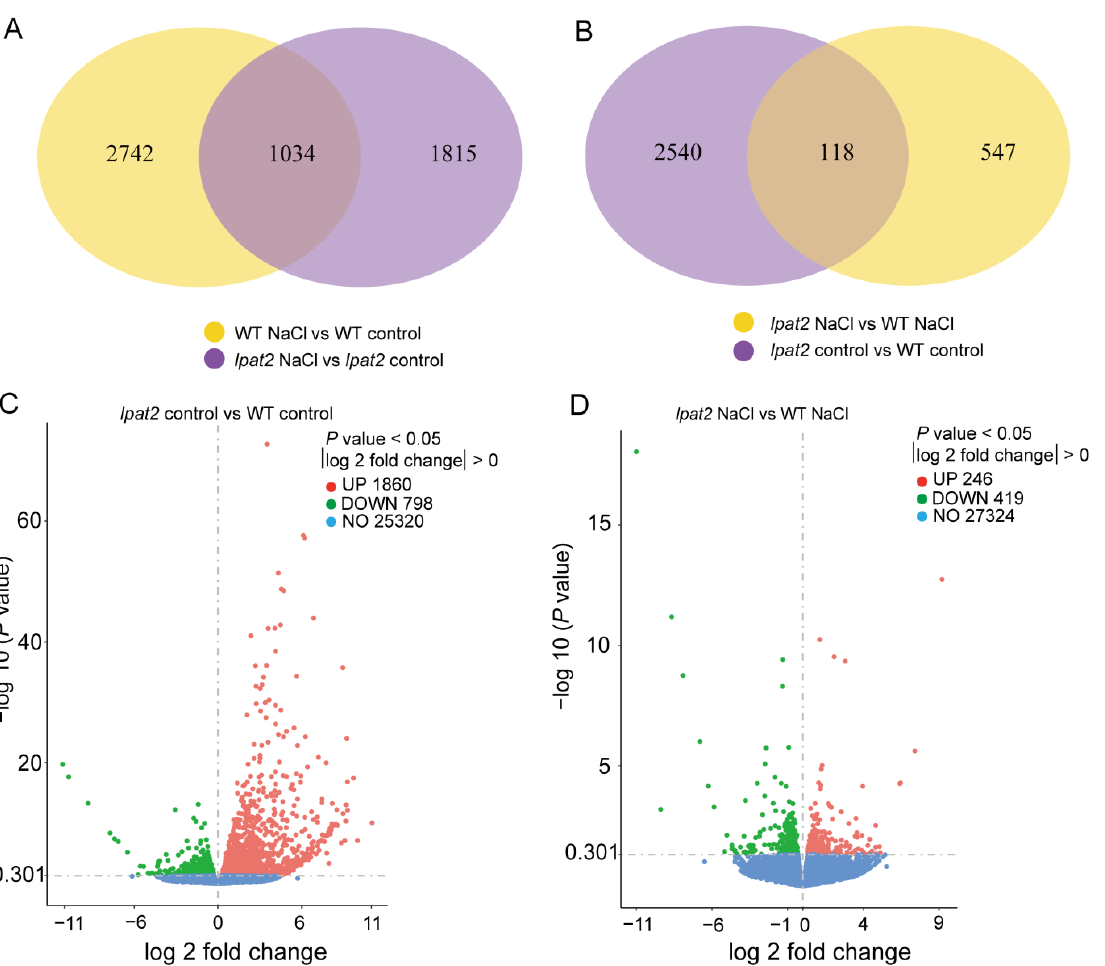
control and salt (100 mM NaCl) stress conditions. ( C ) The numbers of upregulated and downregulated downregulated genes of lpat2 vs. WT under control condition. ( D ) The numbers of upregulated and